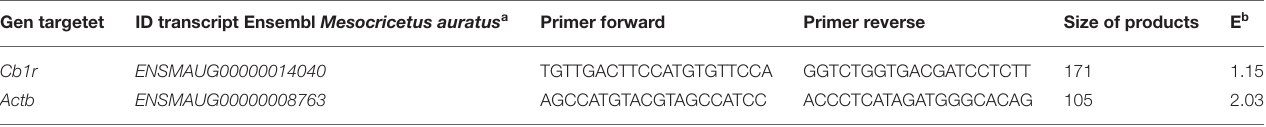
TABLE 1 | Primers used for RT-qPCRs. Gen